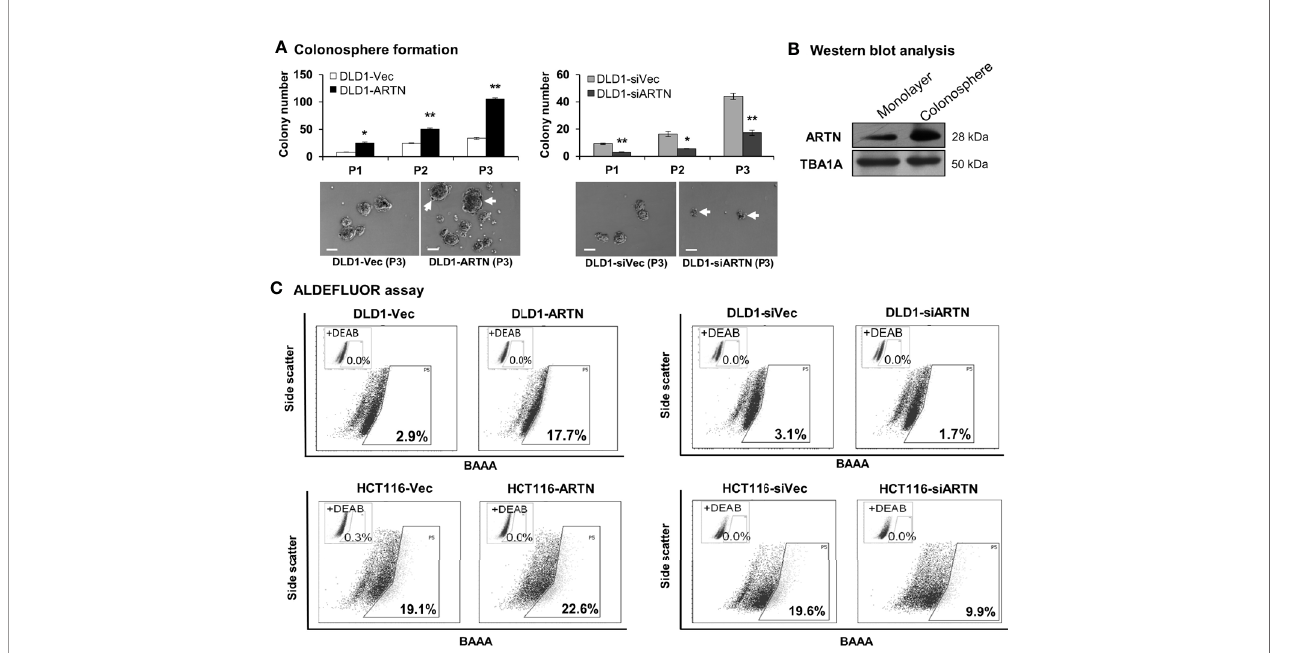
FIGURE 6 | ARTN enhanced stem cell-like properties in DLD1 and HCT116 cells. (A) Serial colonosphere formation assay with DLD1 with either stable forced (left) or depleted (right) expression of endogenous ARTN. The colonospheres were passaged successively twice (P1-P3). For each passage of the colonospheres, the initial singular 100 cells were seeded in each well with triplicates and cultured for 7 days before re-seeding. The number of colonospheres ( ≥ 100µm in diameter) in each well was counted and presented as the average of the triplicate. The images of the P1 colonospheres were captured under a microscope. Scale bar, 100 µm. (B) Western blotting analysis for the expression of ARTN in the whole cell lysate of monolayer culture or colonospheres of DLD1 cells. (C) , ALDEFLUOR (ALDH1 activity) assay on DLD1 and HCT116 cells with stable forced expression of ARTN (left) or depletion of endogenous ARTN (right). * p < 0.05, ** p <